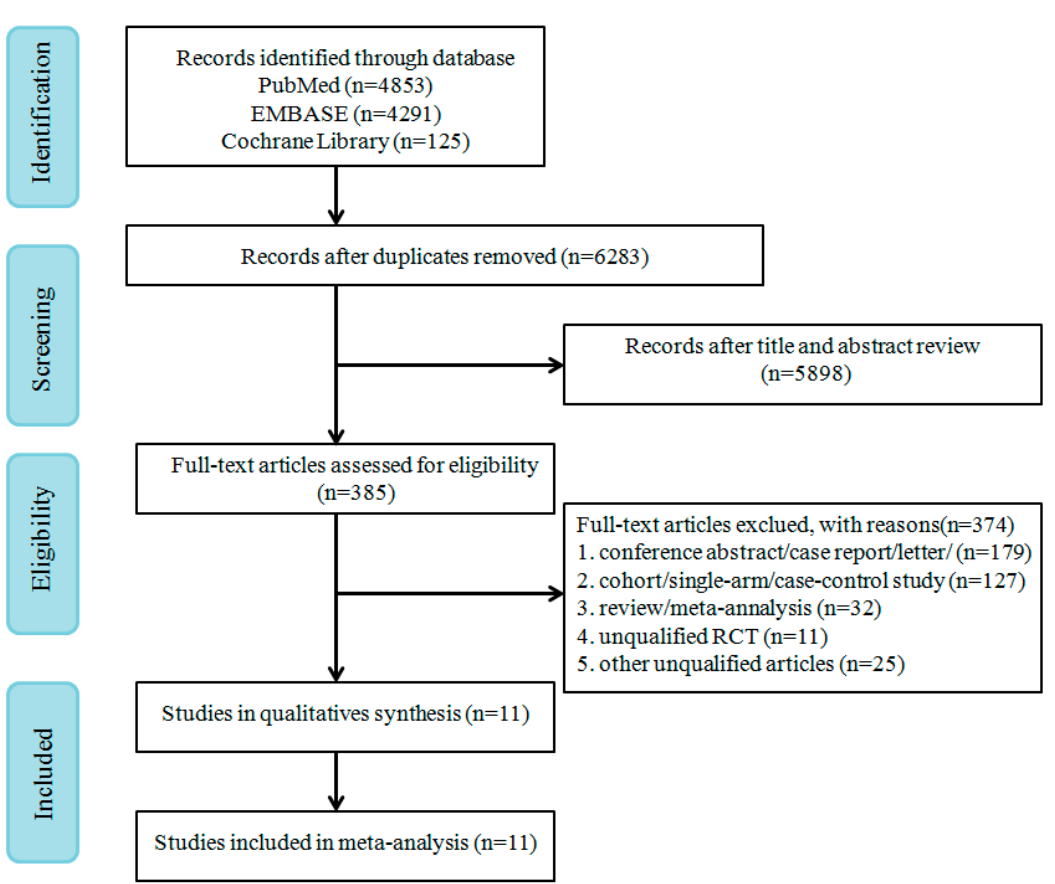
Figure 1. PRISMA flow diagram of randomized controlled trials (RCTs) of patients treated with oncolytic virus.